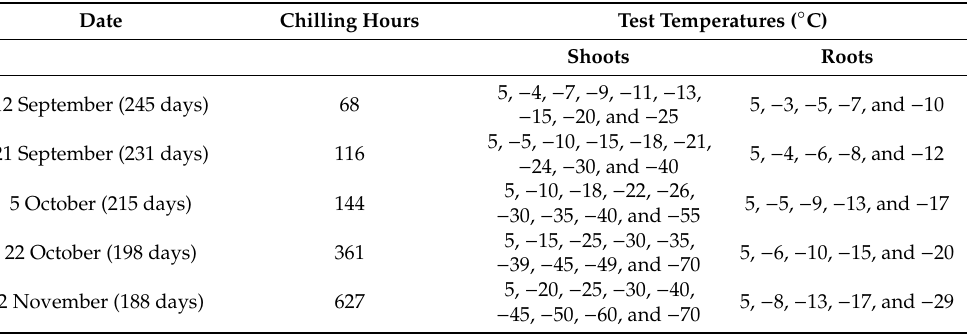
Table 1. Dates of the freezing tests in autumn 2012, accumulated chilling hours (sum of hours when − 5 ≤ T ≥ 5 ◦ C) and test temperatures used. Durations of freezer storage for di ff erent storage dates are indicated in